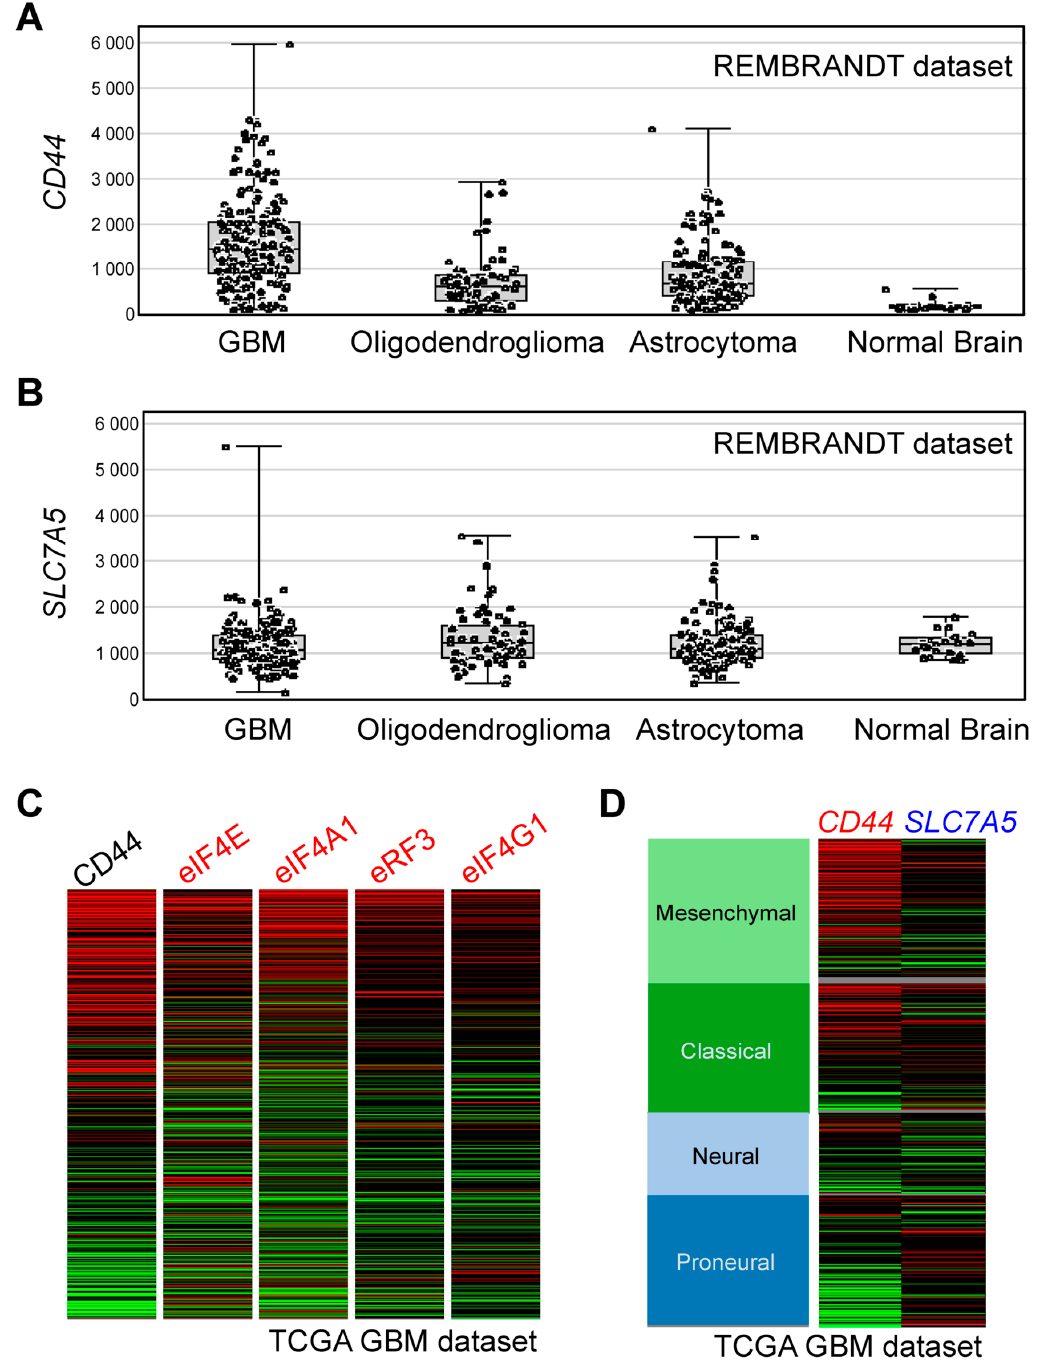
Figure 8. BSH-polyR may contribute to the therapeutic optimization of BSH-BNCT. ( A ) Expression levels of CD44 in brain tumor samples were higher than those in normal brains. ( B ) Profiles of the expression levels of SLC7A5 in brain tumor samples and normal brains. ( C ) Patients with high CD44 expression levels tended to harbor high expression levels of the genes encoding translation-related proteins. ( D ) Profiles of the expression levels of CD44 and SLC7A5 in the The Cancer Genome Atlas (TCGA) glioblastoma (GBM) dataset.